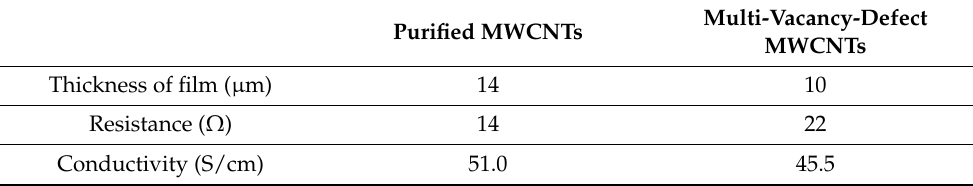
Table 3. Electrical conductivity value.